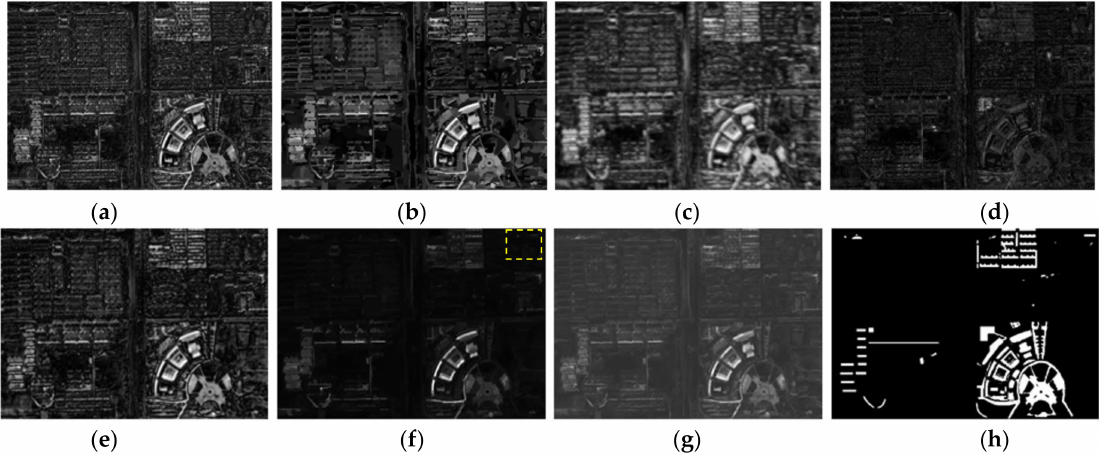
Figure 6. DIs of Mingfeng data set generated by different methods: ( a ) CVA; ( b ) OCVA; ( c ) DCVA;